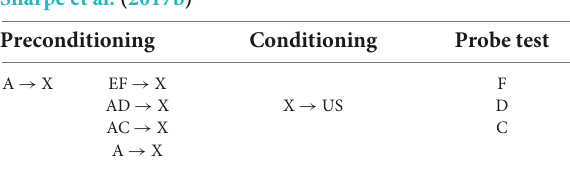
TABLE 1 Blocking during sensory